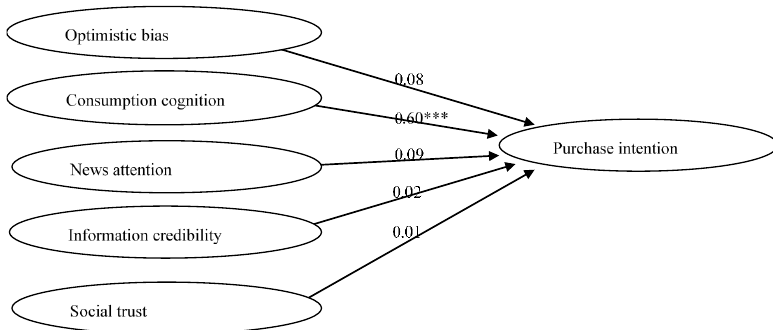
Figure 2. Path coe ffi cient results of alternative model of the Taiwan sample. Note: *** p < 0.001; Figure 2. Path coefficient results of alternative model of the Taiwan sample. Note: *** p < 0.001; χ 2 = 1348.26; df = 424; χ 2 /df (NC) = 3.17; CFI = 0.91; RMSEA = 0.092. χ 2 = 1348.26; df = 424; χ 2 / df (NC) = 3.17; CFI = 0.91; RMSEA = 0.092.